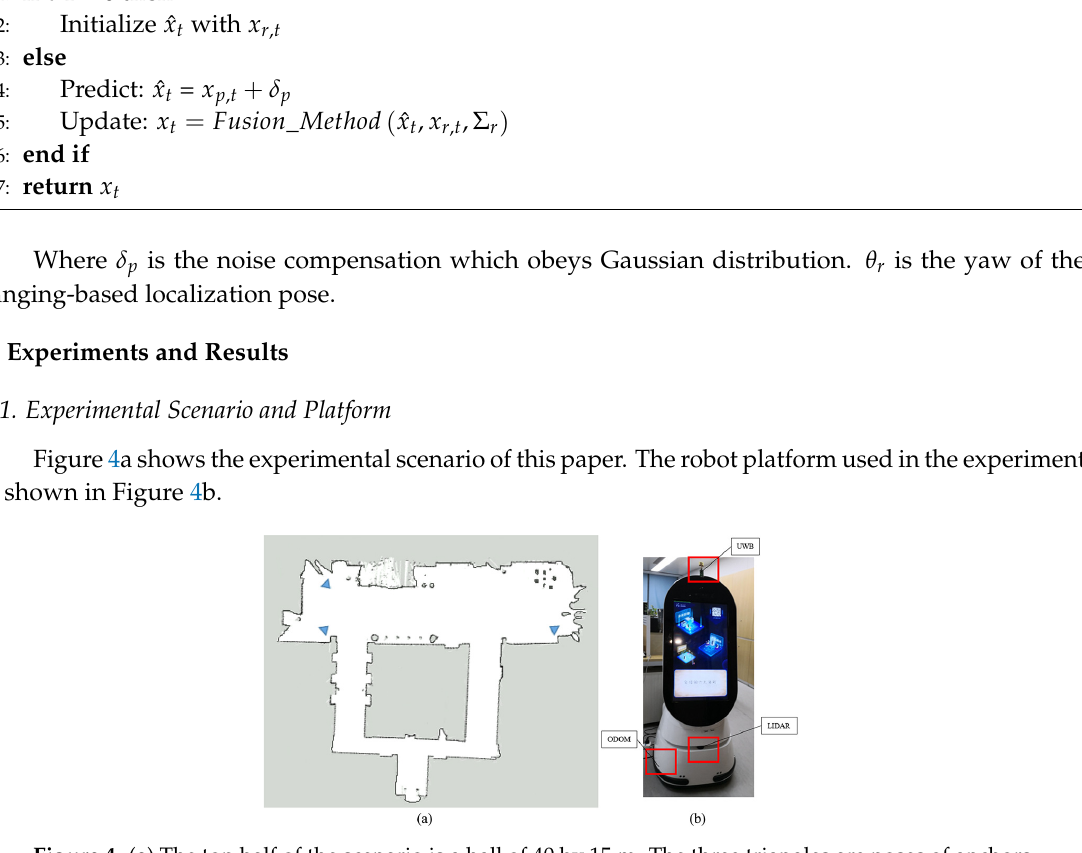
Figure 4. ( a ) The top half of the scenario is a hall of 40 by 15 m. The three triangles are poses of anchors. ( b )The robot platform is equipped with odometry, lidar, and